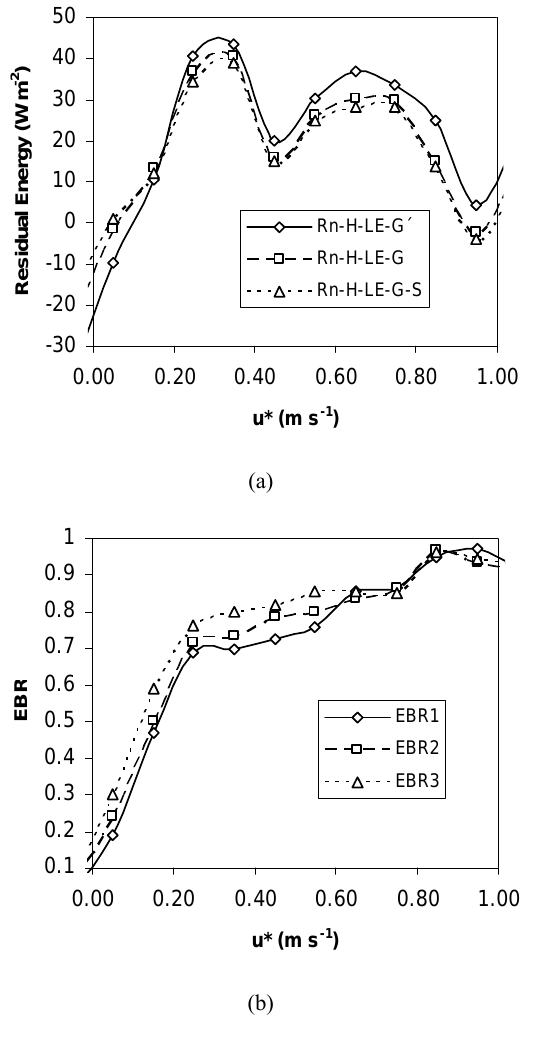
Fig. 3. Effect of the friction velocity u ∗ on: (a) the residual energy, (b) the energy balance ratio. Values indicate averages in each range of u ∗ .